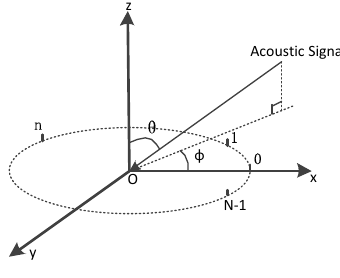
Figure 3. Virtual uniform circular arrays geometry